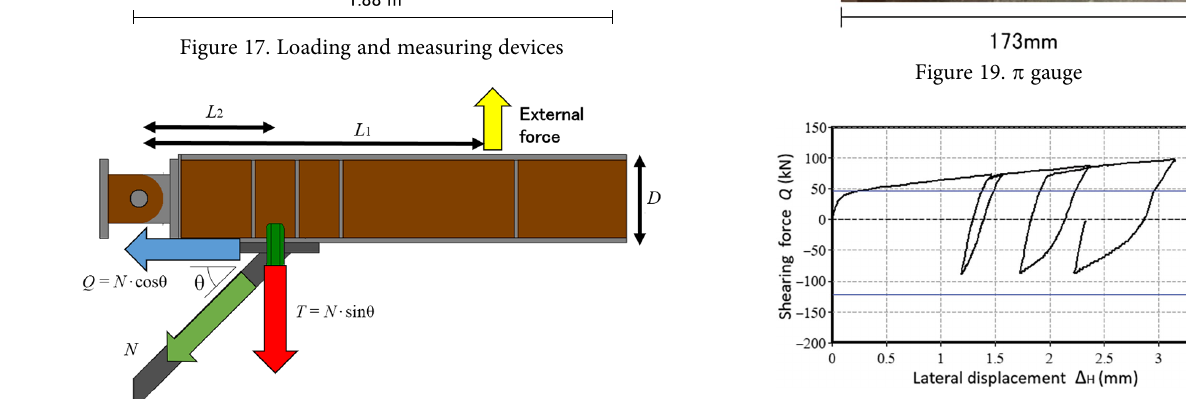
Figure 18. Equilibrium of forces